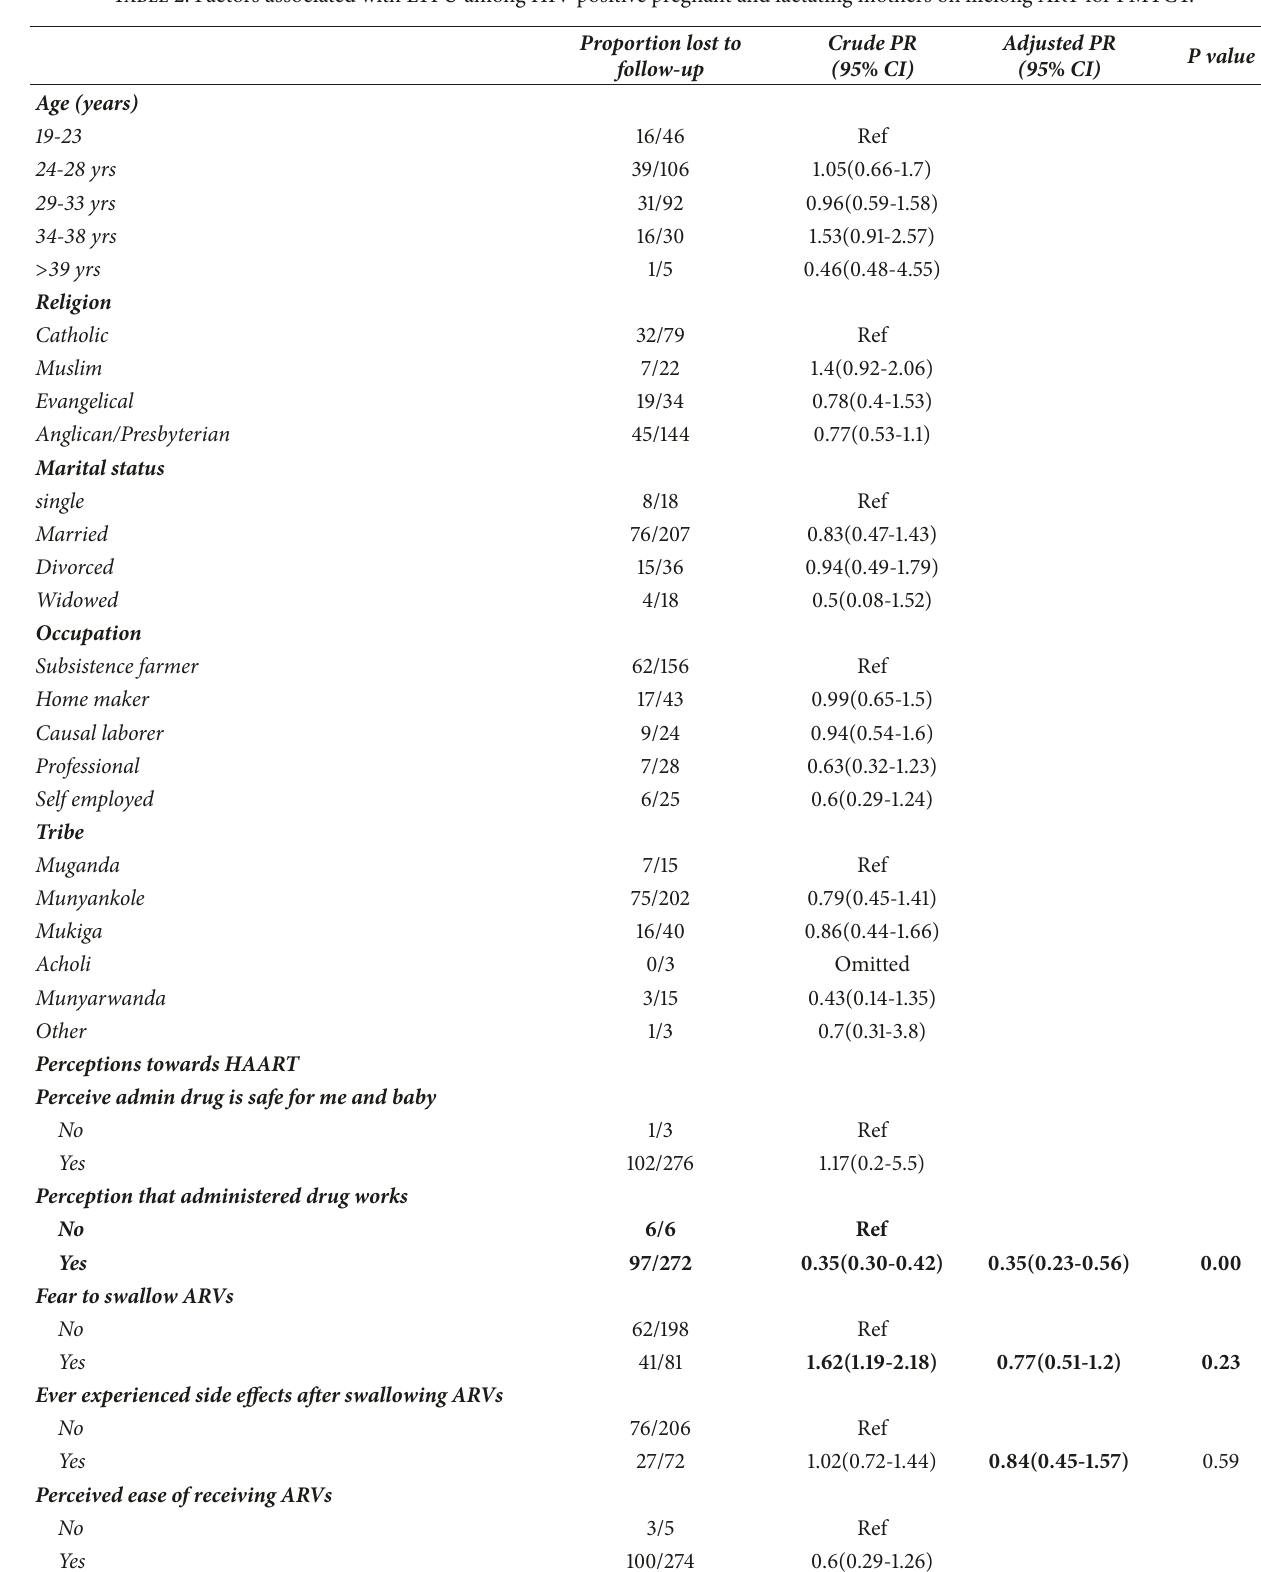
Table 2: Factors associated with LTFU among HIV positive pregnant and lactating mothers on lifelong ART for